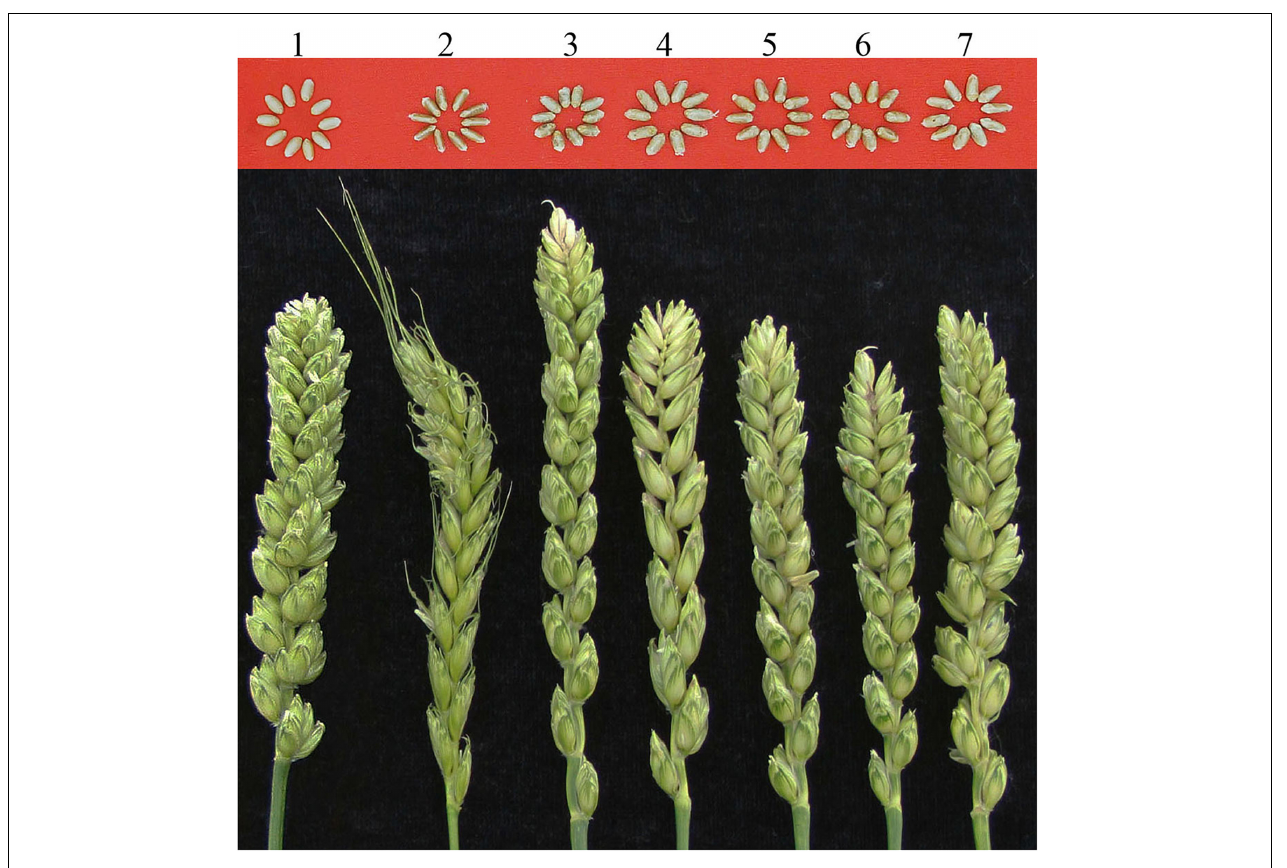
FIGURE 5 | Spike and grain morphologies of wheat- A. sharonensis chromosome lines. Grain and spikes from left to right are CS, CS- A . sharonensis 2S sh disomic addition, 4S sh disomic addition, 4S sh (4D) substitution + 5S sh L monotelosomic addition, 6S sh disomic addition, 4S sh (4D) substitution + 6S sh disomic addition and 4S sh (4D) substitution + 7S sh disomic addition lines, respectively. TABLE 3 | The chromosome composition and Stripe rust, leaf rust, stem rust, and powdery mildew infection types of JIC-32 to JIC-37. Line 2n Chromosome composition Stripe rust Leaf rust Stem rust Powdery